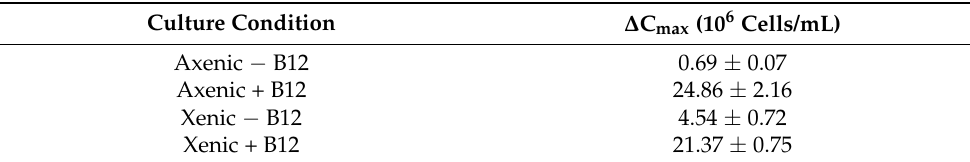
Figure 3. Co-culture experiment of T. lutea with a complex microbial consortium with different B 12 availability levels (means of n = 3 biological replicates ± standard deviation of the mean). Table 3. Maximal biomass increase of T. lutea culture experiments with a complex microbial consor- tium, with or without cobalamin input.